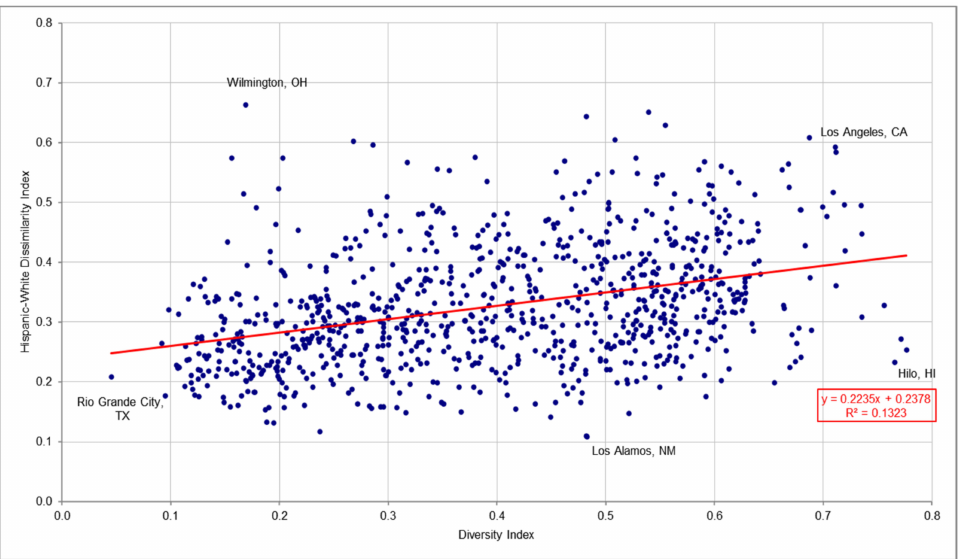
Figure 23. Relationship Between Diversity and Hispanic-White dissimilarity. Native American-White dissimilarity and diversity had a weak and inverse relation- ship. The correlation coefficient was − 0.052. The slope was − 0.00384. Thus, the higher the diversity index, the lower the Native American-White Dissimilarity Index (Figure 24). Asian-white Dissimilarity and diversity had a correlation coefficient of 0.127 and a slope of 0.0706. The relationship was positive but weak (Figure 25). The relationship between racial diversity and racial isolation was more consistent. Black isolation and diversity had a correlation coefficient of 0.482. The relationship had a solid positive slope of 0.554. The greater the diversity of metro/micro areas, the more isolated blacks were (Figure